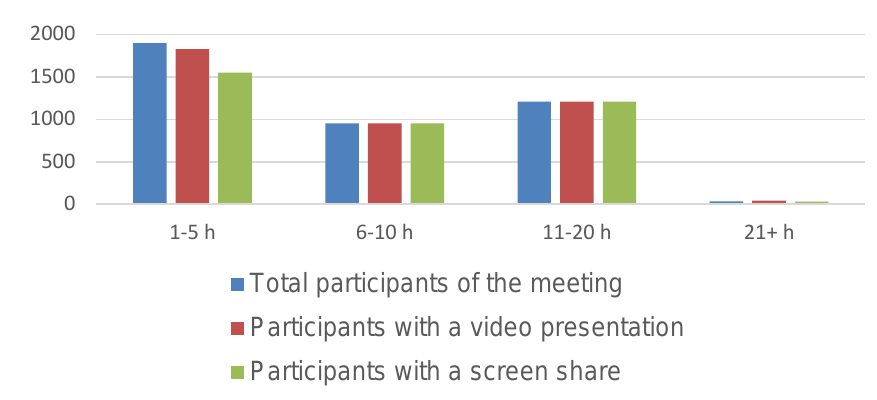
Figure 1 – The amount of time spent on the platform in one week of lectures Слика 1 – Количина проведеног времена на платформи у једној недељи